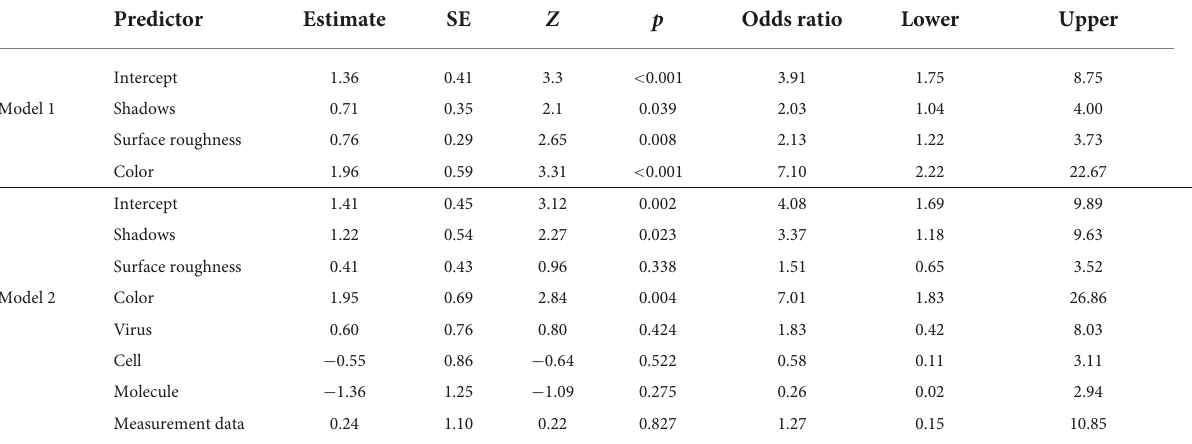
TABLE 4 Binary logistic regression analysis of participants’ assessment of whether images look like real objects.